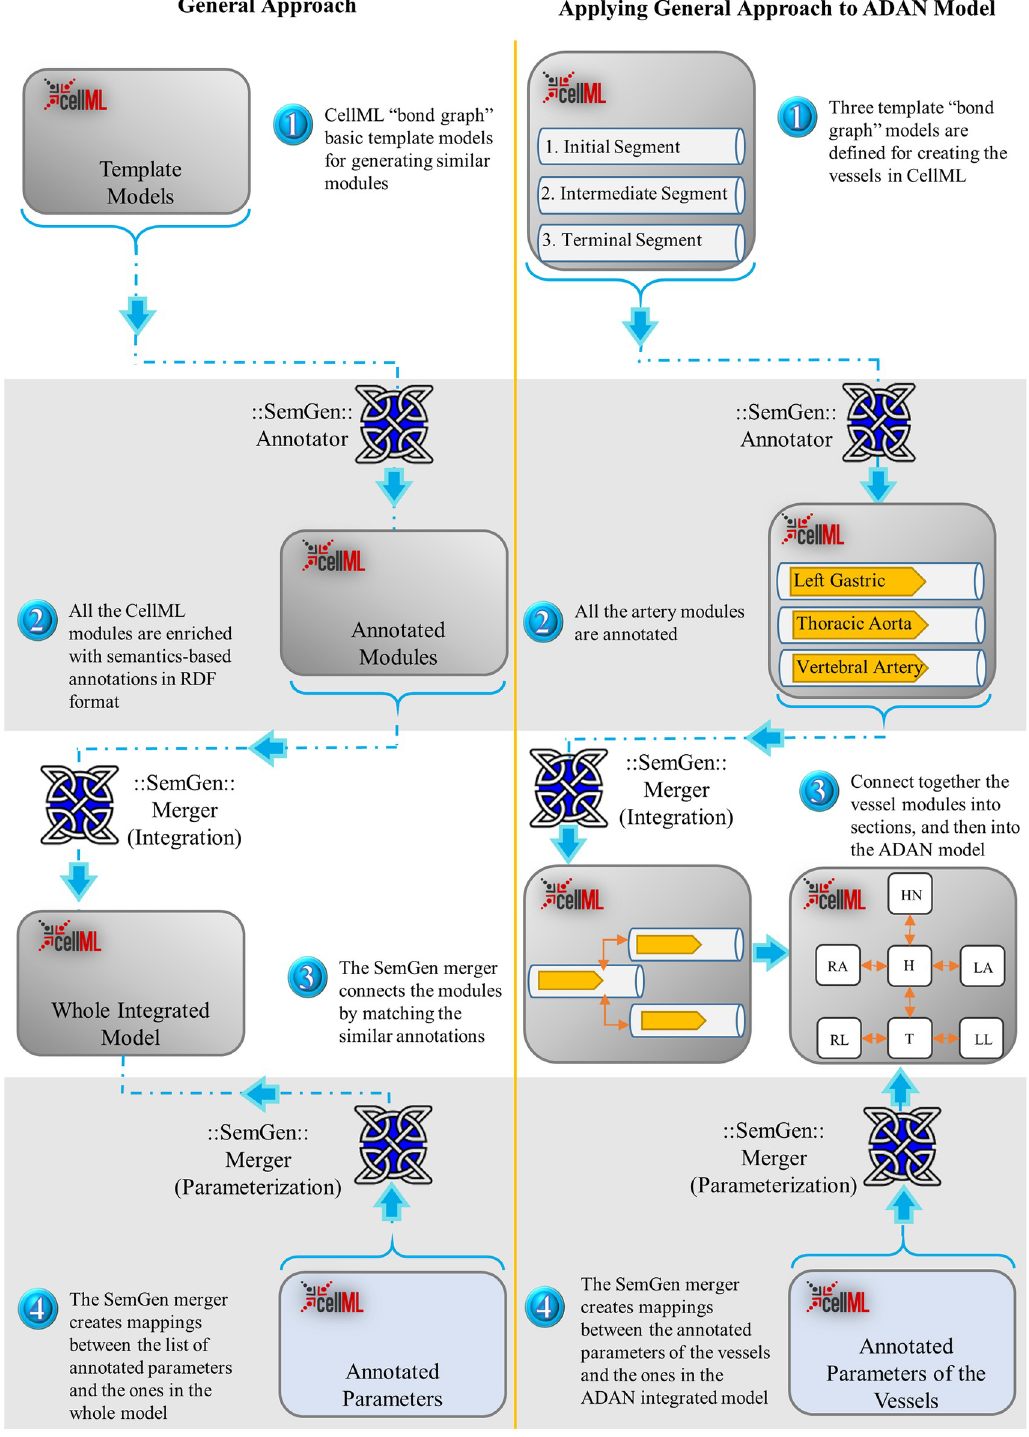
Fig 1. Flowchart of the semantics-based automated model composition method. The left column illustrates the general approach in the integration of bond graph models in CellML using SemGen, and the right column shows the same procedure specific to the ADAN circulation model. In both approaches, the bond graph models are created based on template models (1), and annotated using the SemGen Annotator (2). Later, depending on whether the system has similar larger compartments or any symmetry, the SemGen merger tool joins the modules in a number of steps (3). The amounts for the symbolic model parameters are allocated from a CellML file containing the annotated parameters and their values (4). In stage (3): HN: Head and Neck, H: Heart, RA: Right Arm, LA: Left Arm, T: Trunk, RL: Right Leg, LL: Left Leg.